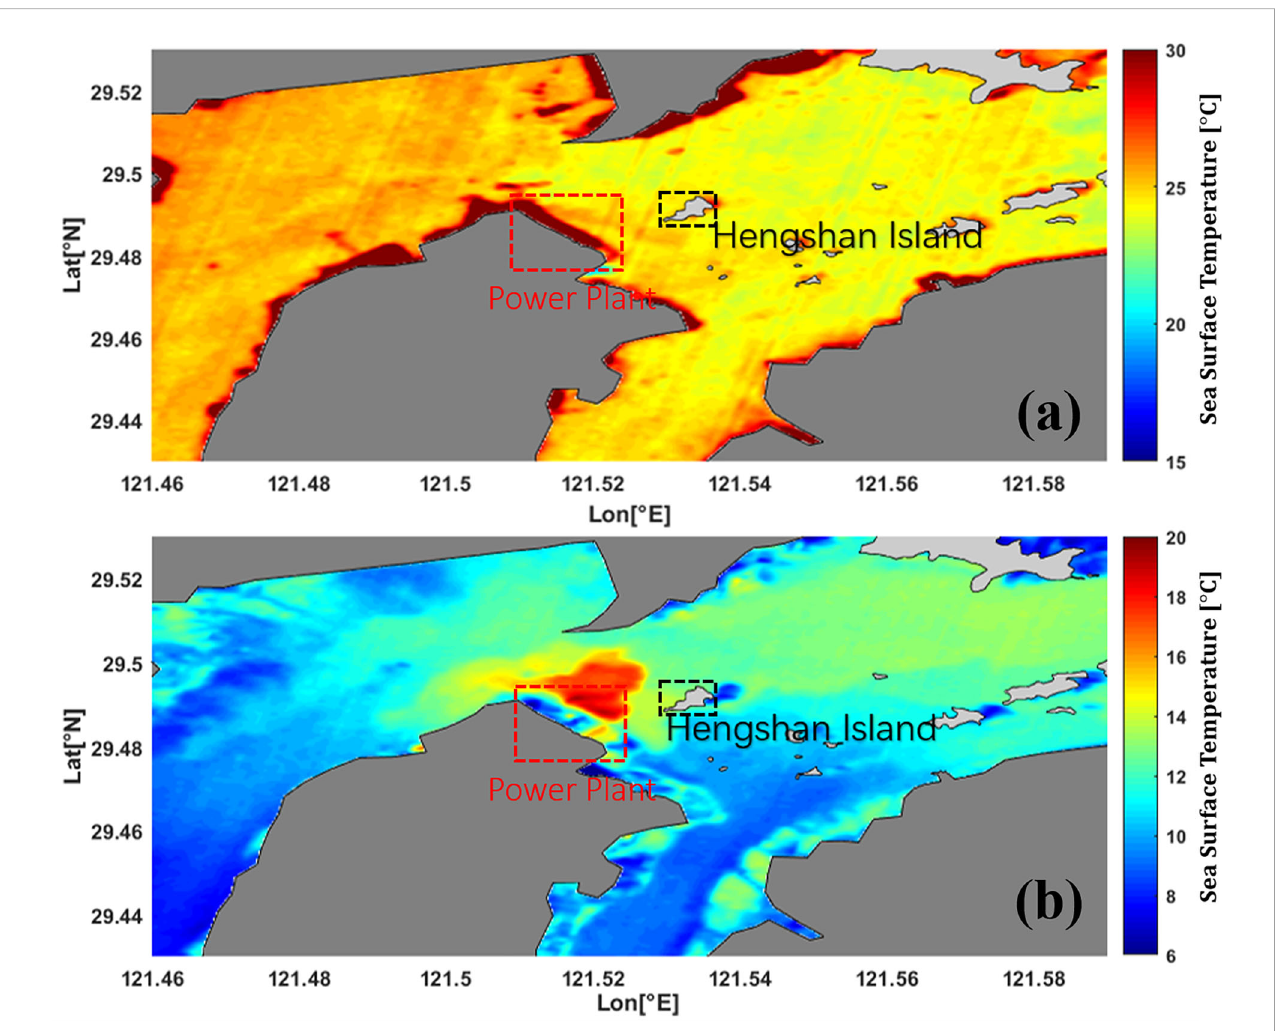
FIGURE 3 Remote sensing inversion of sea surface temperature (SST) near Ninghai Power Plant: (A) summer (July 29, 2019) and (B) winter (December 2,